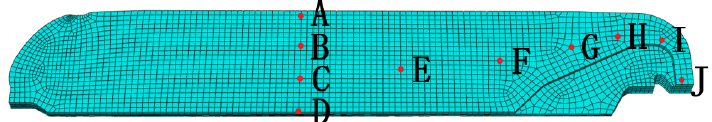
Figure 7. Node selection. Figure 8 plots the temperature and curing degree of each node with curing time.